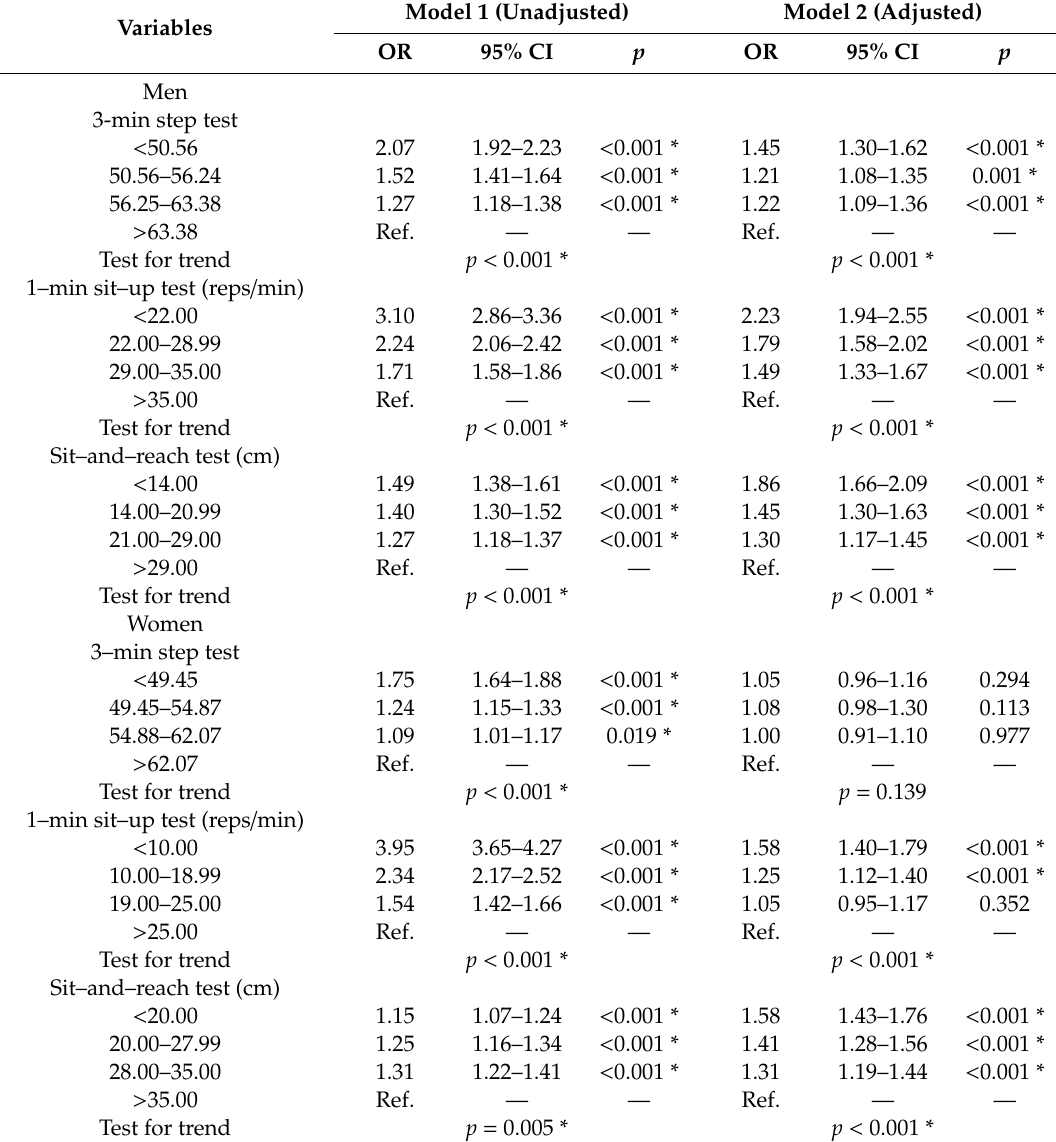
Table 4. Multivariate adjusted ORs for abdominal obesity in relation to the quartiles of health-related physical fitness measurements after adjustment for potential